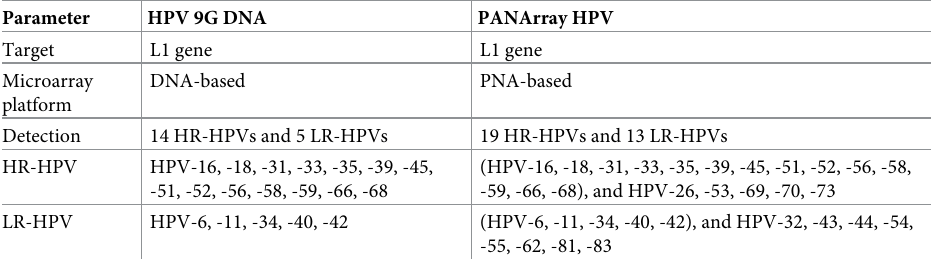
Table 1. Comparison of features of HPV chip